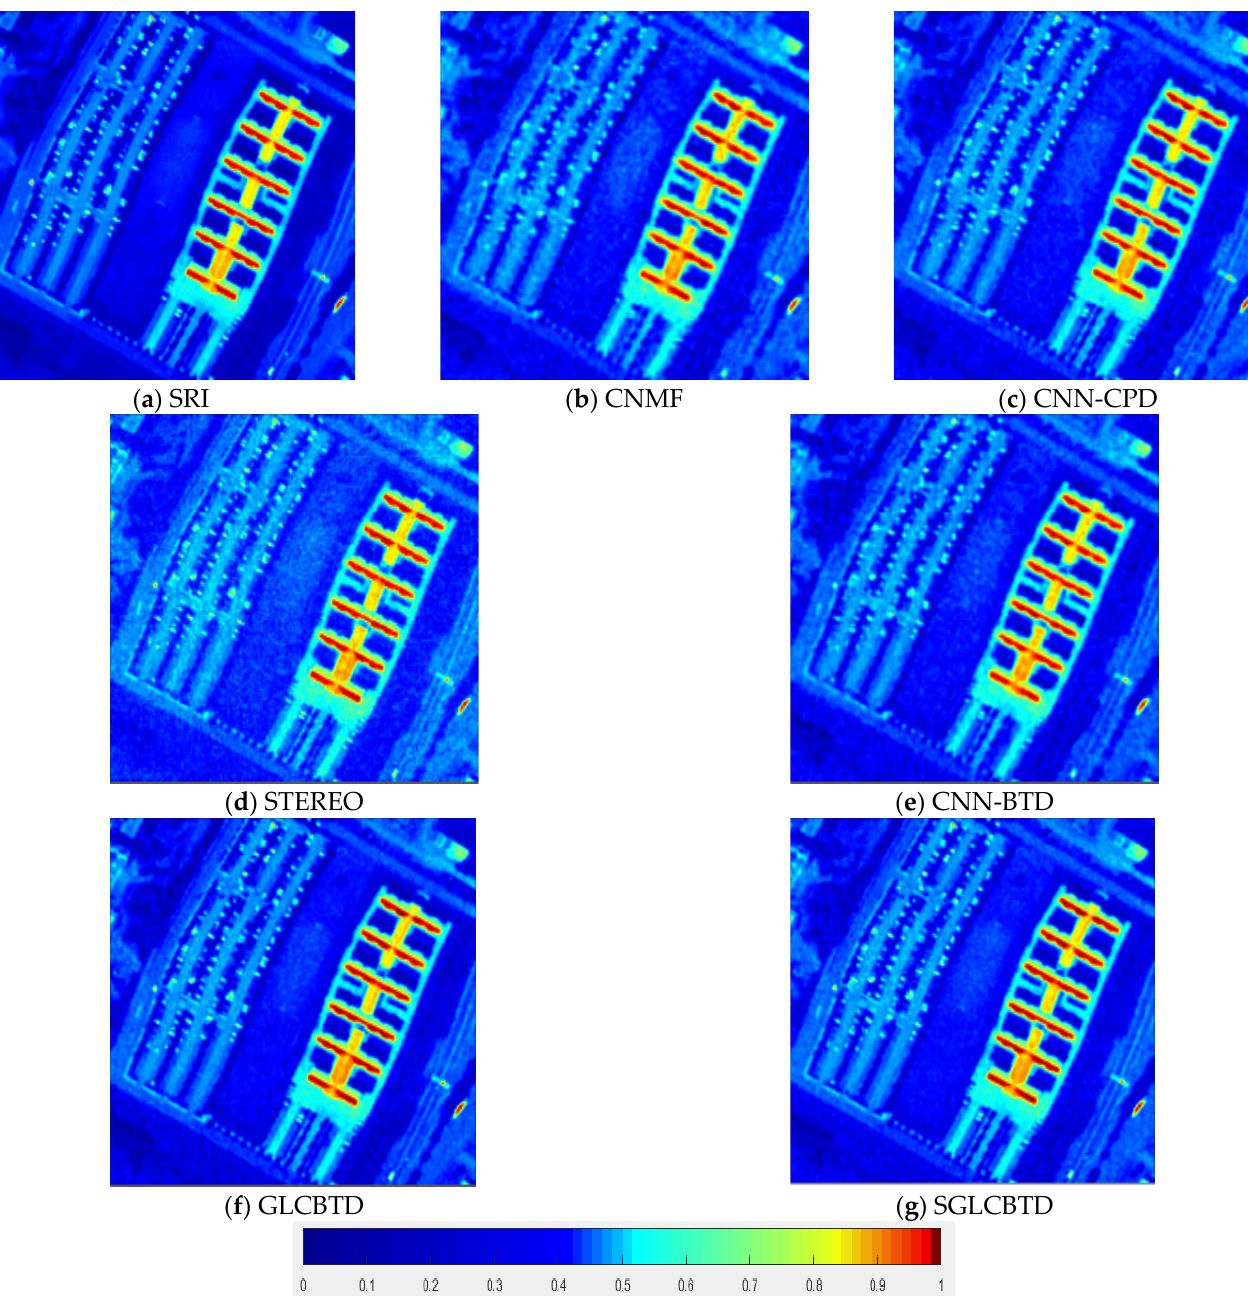
Figure 7. Comparisons of fusion results of the 10-th band on the Pavia University dataset.